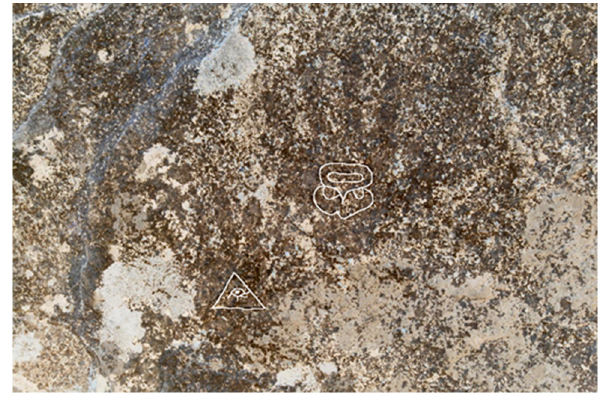
Figure 37. Truckee CA, Locus 3. Photo digital enhancement of one of three pairs of handprints found at this site. Notice the bent thumb on the upper hand. A lone seventh print appears on an isolated boulder at Locus 4.